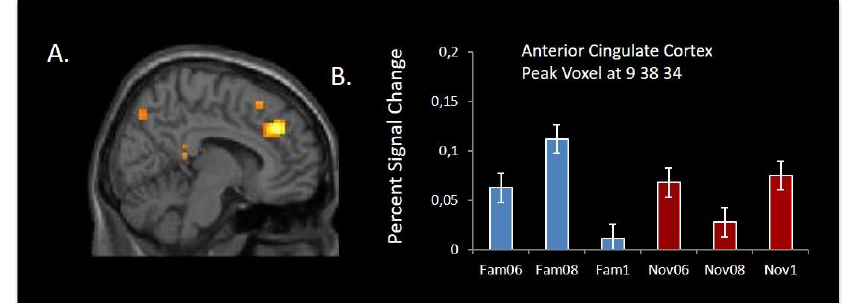
Figure 5. (a) Interaction contrast overlaid on medial frontal gyrus showing significant interaction between uncertainty and novelty ( p < 0.001, a minimum cluster size (k) = 10 voxels). (b) Percent signal change for the peak voxel in the anterior cingulate gyrus.